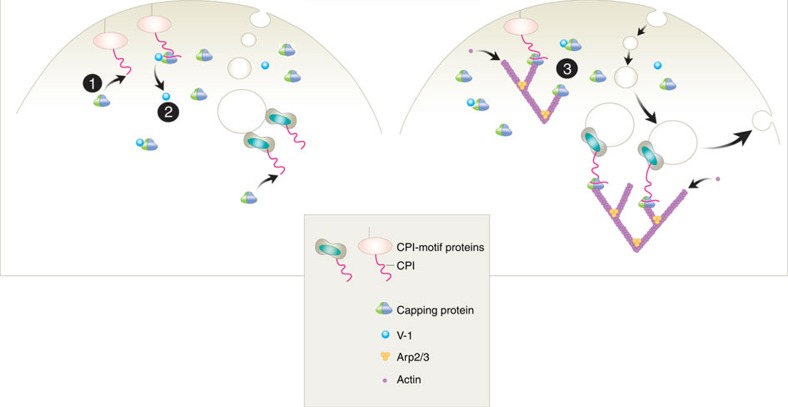
CP localization and function requires interaction with CPI-motif proteins.CPI-motif proteins facilitate the recruitment of free cytosolic CP to biological membranes via the CPI motif (1). The CPI–CP interaction accelerates the dissociation of V-1 bound to CP (2). CPI–CP complex caps the barbed end of growing actin filaments near the membrane and promotes dendritic actin network growth and dynamics (3).